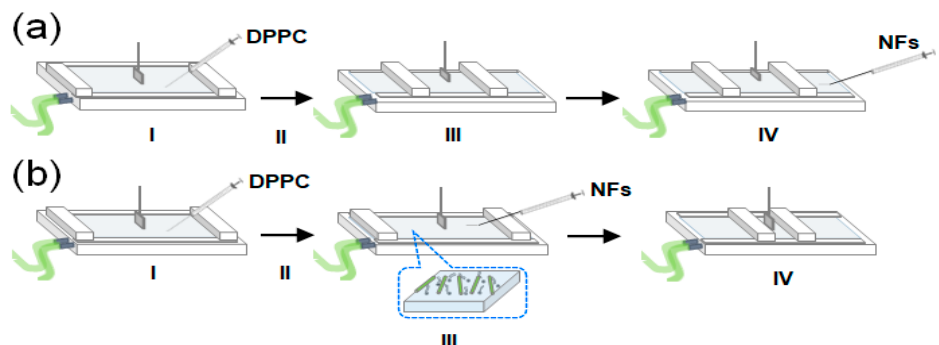
Figure 2. Schematic of the experimental procedure: ( a ) change in surface pressure after the injection of EG n NFs into the subphase; (I) spread of DPPC in chloroform on phosphate buffered saline (PBS) subphase using a micro-syringe, (II) chloroform evaporation, (III) prefabrication of DPPC membrane with a surface pressure of ~30 mN/m, and (IV) injection of NFs into the subphase using a micro-syringe; ( b ) π – A compression isotherm of DPPC in the presence of NFs; (I) spread of DPPC in chloroform on the PBS subphase using a micro-syringe, (II) chloroform evaporation, (III) injection of NFs into the subphase using a micro-syringe, and (IV) compression of the DPPC membrane at a speed of 2 mm/min .